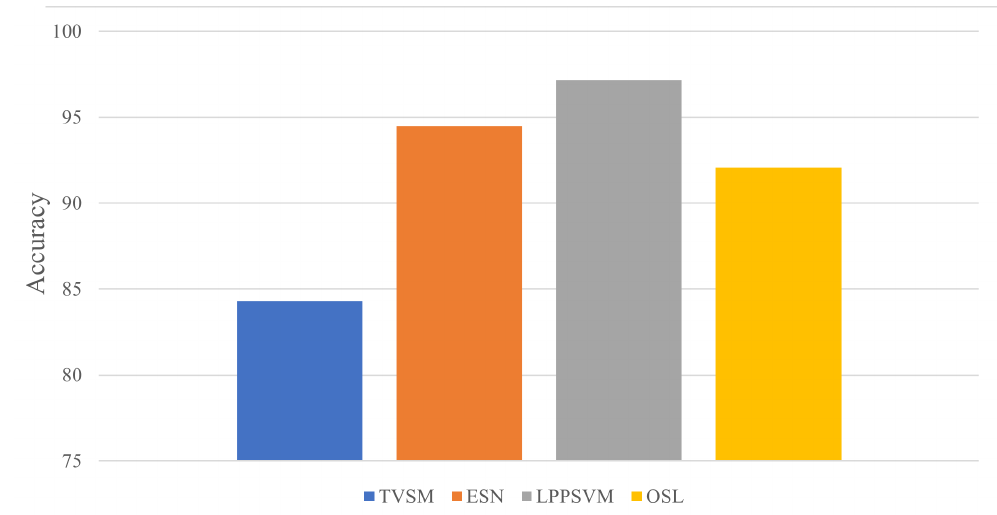
Figure 5. Comparison of novel sensor (magnetic field signal) [39] to conventional sensors (attitude sensor) in [41,44,46] for mechanical fault diagnosis of 3D delta